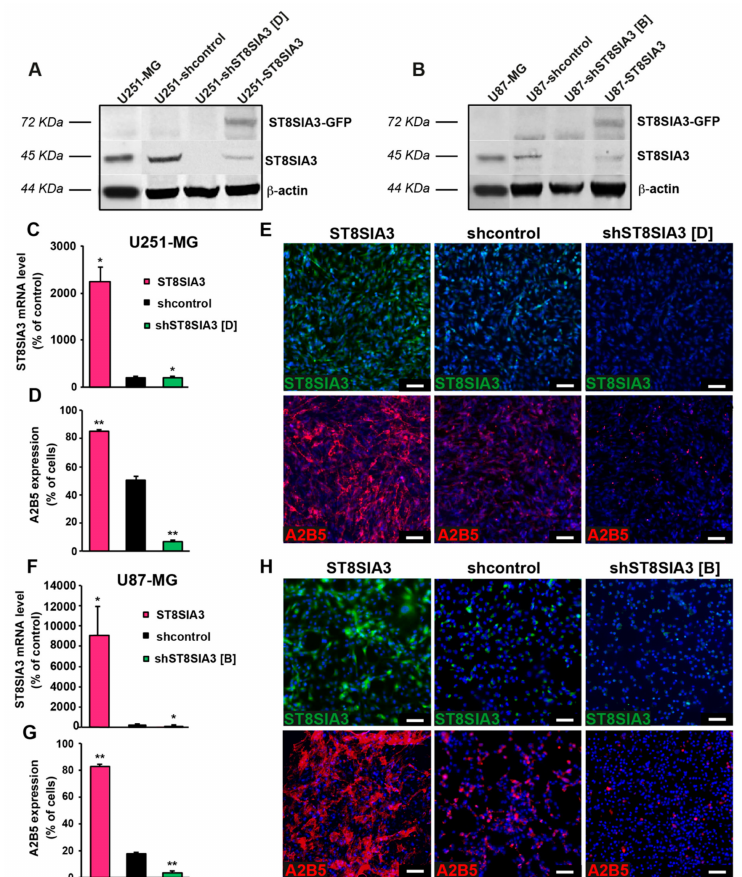
Figure 1. Expression of ST8 alpha-N-acetyl-neuraminidase α -2,8-sialyltransferase 3 (ST8SIA3) drives A2B5 immunoreactivity. ( A ) Western blot analysis of ST8SIA3-GFP (72 KDa) and endogenous ST8SIA3 (45 KDa) in U251-MG, U251-shcontrol, U251-shST8SIA3 [D], and U251-ST8SIA3 cell lines. The expression level of β -actin (44 KDa) was used as a loading control. Ratios of ST8SIA3 / β -actin relative to U251-shcontrol from 3 independent experiments are presented under the blot. ( B ) Western blot analysis of ST8SIA3-GFP and endogenous ST8SIA3 in U87-MG, U87-shcontrol, U87-shST8SIA3 [B], and U87-ST8SIA3 cell lines. The expression level of β -actin was used as a loading control. Ratios of ST8SIA3 / β -actin relative to U87-shcontrol from 3 independent experiments are presented under the blot. ( C ) RT-qPCR demonstration of ST8SIA3 overexpression in the U251-ST8SIA3 cell line after lentiviral infection and comparison with U251-shcontrol and U251-shST8SIA3 [D] cell lines. Data from five independent experiments are expressed as mean ± SEM. ( D ) Flow cytometry analysis of A2B5 in the U251-ST8SIA3 cell line and comparison with U251-shcontrol and U251-shST8SIA3 [D] cell lines. Data from six independent analyses are expressed as mean ± SEM. ( E ) Immunofluorescence staining of ST8SIA3 (green) and A2B5 (red) in U251-ST8SIA3, U251-shcontrol, and U251-shST8SIA3 [D] cell lines. Hoechst staining of the cell nuclei (blue) is also shown. Scale bar = 50 µ m. ( F ) RT-qPCR demonstration of ST8SIA3 overexpression in the U87-ST8SIA3 cell line after lentiviral infection and comparison with U87-shcontrol and U87-shST8SIA3 [B] cell lines. ( G ) Flow cytometry analysis of A2B5 in the U87-ST8SIA3 cell line and comparison with U87-shcontrol and U87-shST8SIA3 [D] cell lines. ( H ) Immunofluorescence staining of ST8SIA3 (green) and A2B5 (red) in U87-ST8SIA3, U87-shcontrol, and U87-shST8SIA3 [B] cell lines. Cell nuclei are in blue. Scale bar = 50 µ m. Non-parametric Wilcoxon-Mann-Whitney test shows * p < 0.05 and ** p <